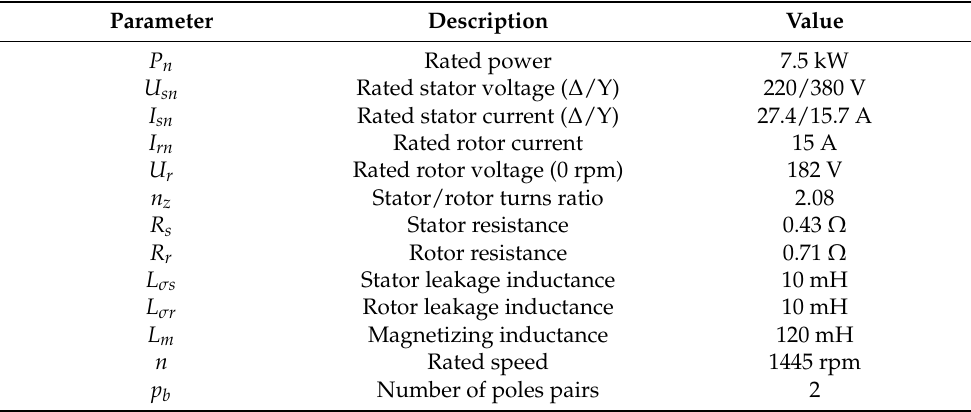
Table 3. Laboratory set-up 7.5 kW DFIG nominal